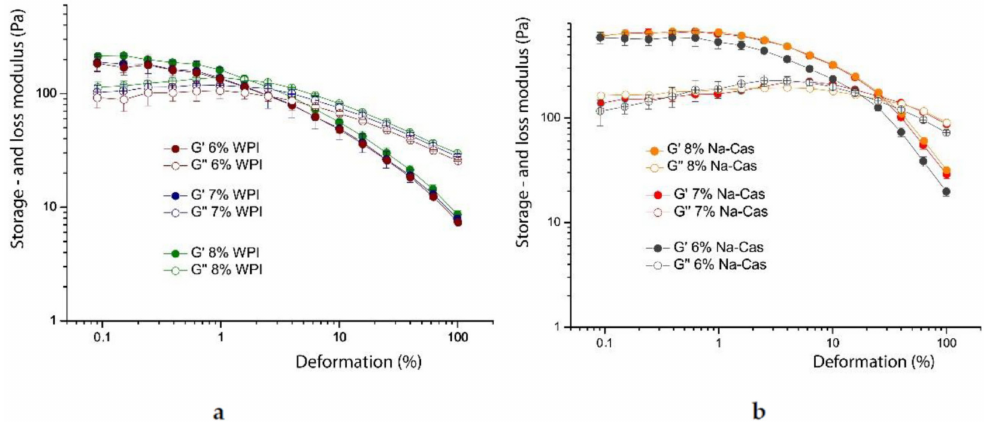
Figure 11. The storage ( G ’) and loss ( G’ ’) modulus in amplitude sweeps of WPI ( a ) and Na-Cas ( b ) in the concentration range from 6 to 8%, each, with 73% oil in water.